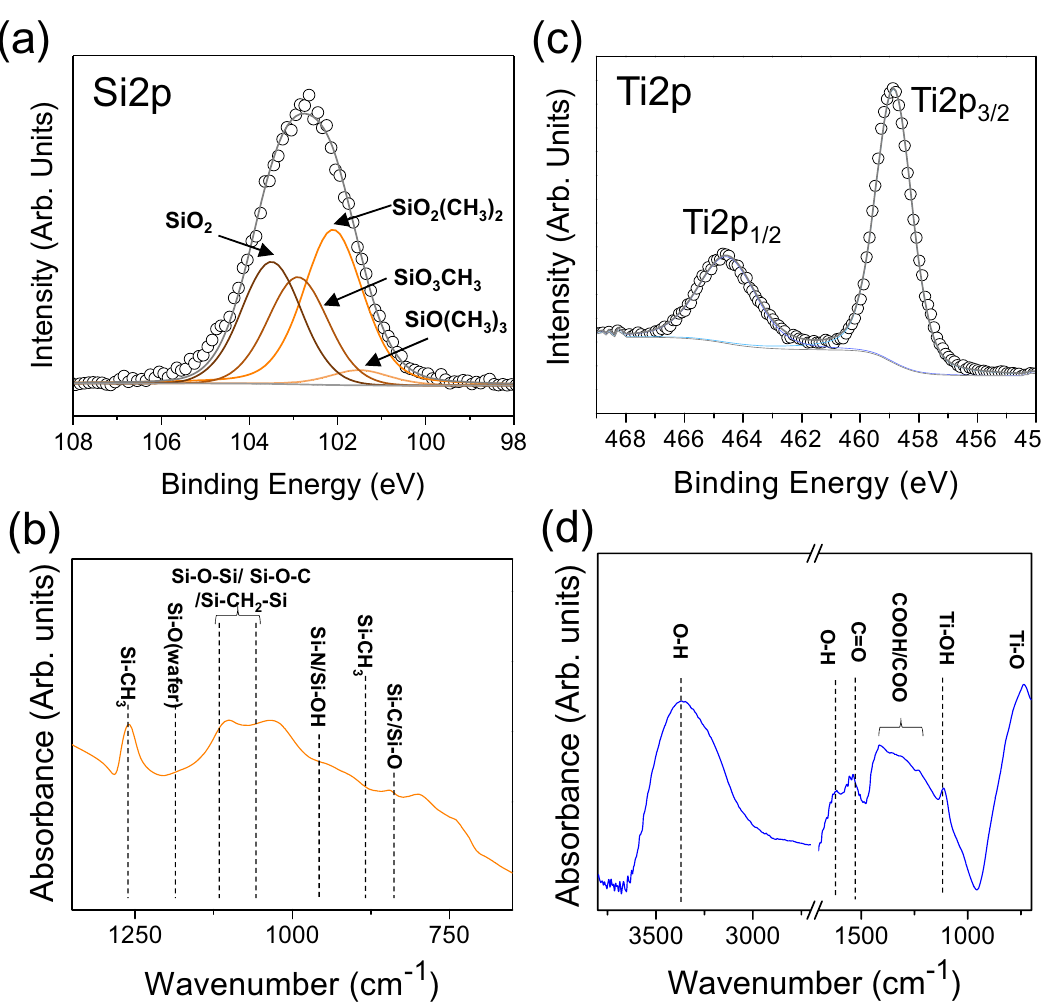
Figure 3. XPS fitting of ( a ) Si2 p and ( c ) Ti2 p core levels for thin films deposited with case 1 and case 2 respectively. FTIR spectra of thin films deposited using ( b ) case 1 and ( d ) case 2